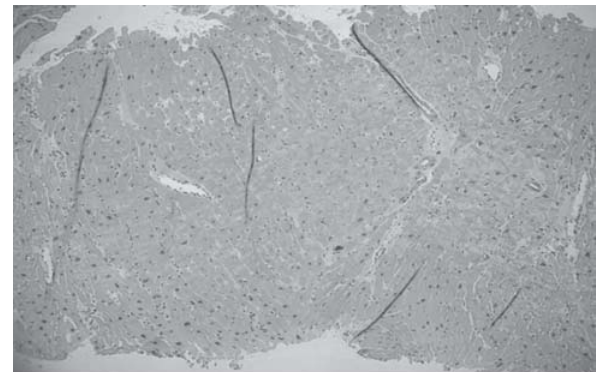
Fig. 4 – Biópsia endomiocárdica com 5 anos de evolução, demonstrando ausência de infiltrado